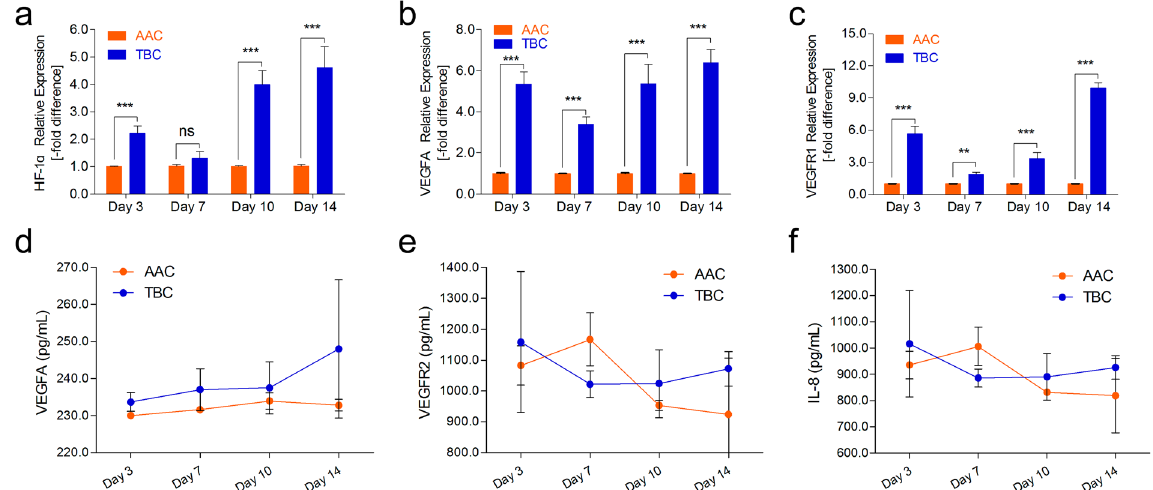
Figure 3. Higher levels of angiogenesis-related mRNA and protein in TBCs. ( a – c ) The mRNA expression levels of HIF-1 α , VEGFA, and VEGFR1 were determined by qRT-PCR. The mRNA expression levels of the AAC were normalized to 1. GAPDH was used as the loading control. The results are representative of at least three independent experiments, which were run in triplicate, and are expressed as the mean ± SD. Student’s t - test, * p < 0.05, *** p < 0.001, n = 3. ( d – f ) The serum protein concentrations of VEGFA, VEGFR2, and IL-8 were measured using an ELISA kit. Student’s t -test, n ≥ 3; Error bars indicate SEM. AAC, Arbor Acres chicken; TBC, Tibetan